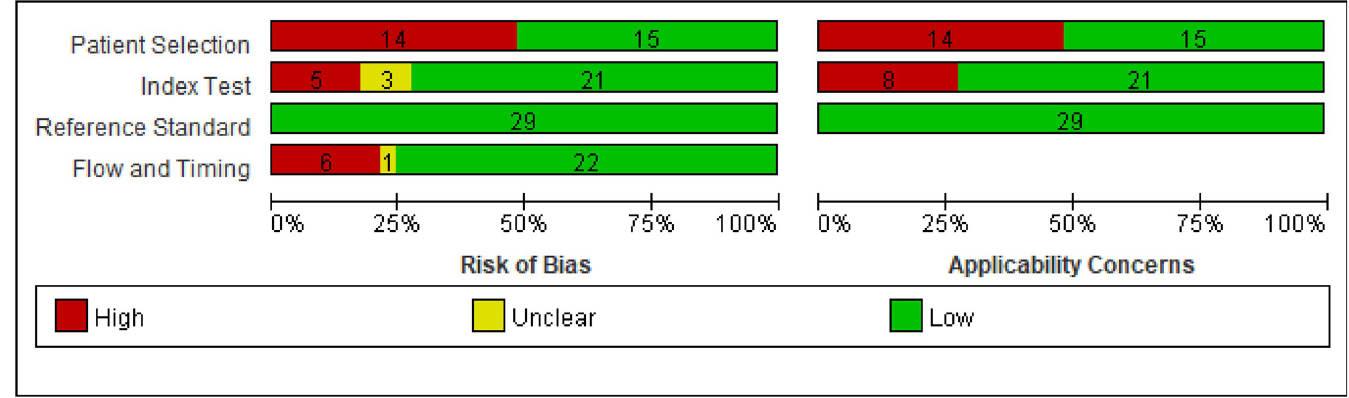
Fig 2. Evaluation of the included studies using Quality Assessment of Diagnostic Accuracy Studies (QUADAS-2) tool. Bias risk and applicability concerns were analyzed in all studies and categorized into high (red), low (green) and unclear (yellow).